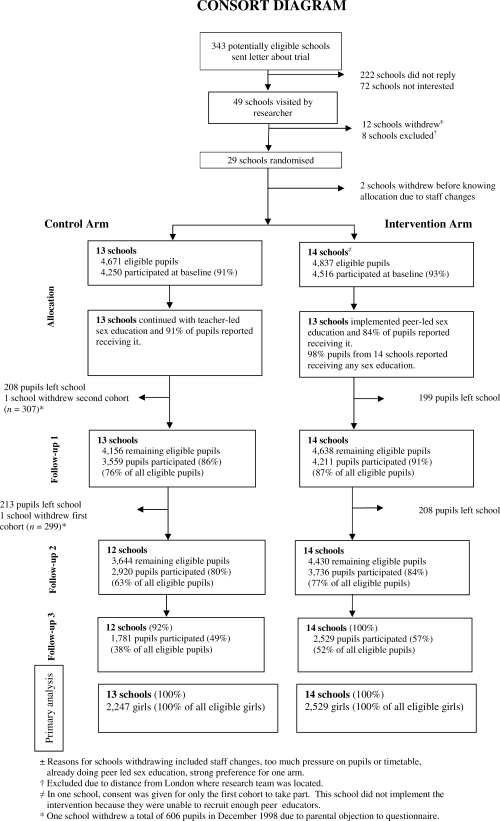
Consort DiagramFlow diagram of participants in the trial.